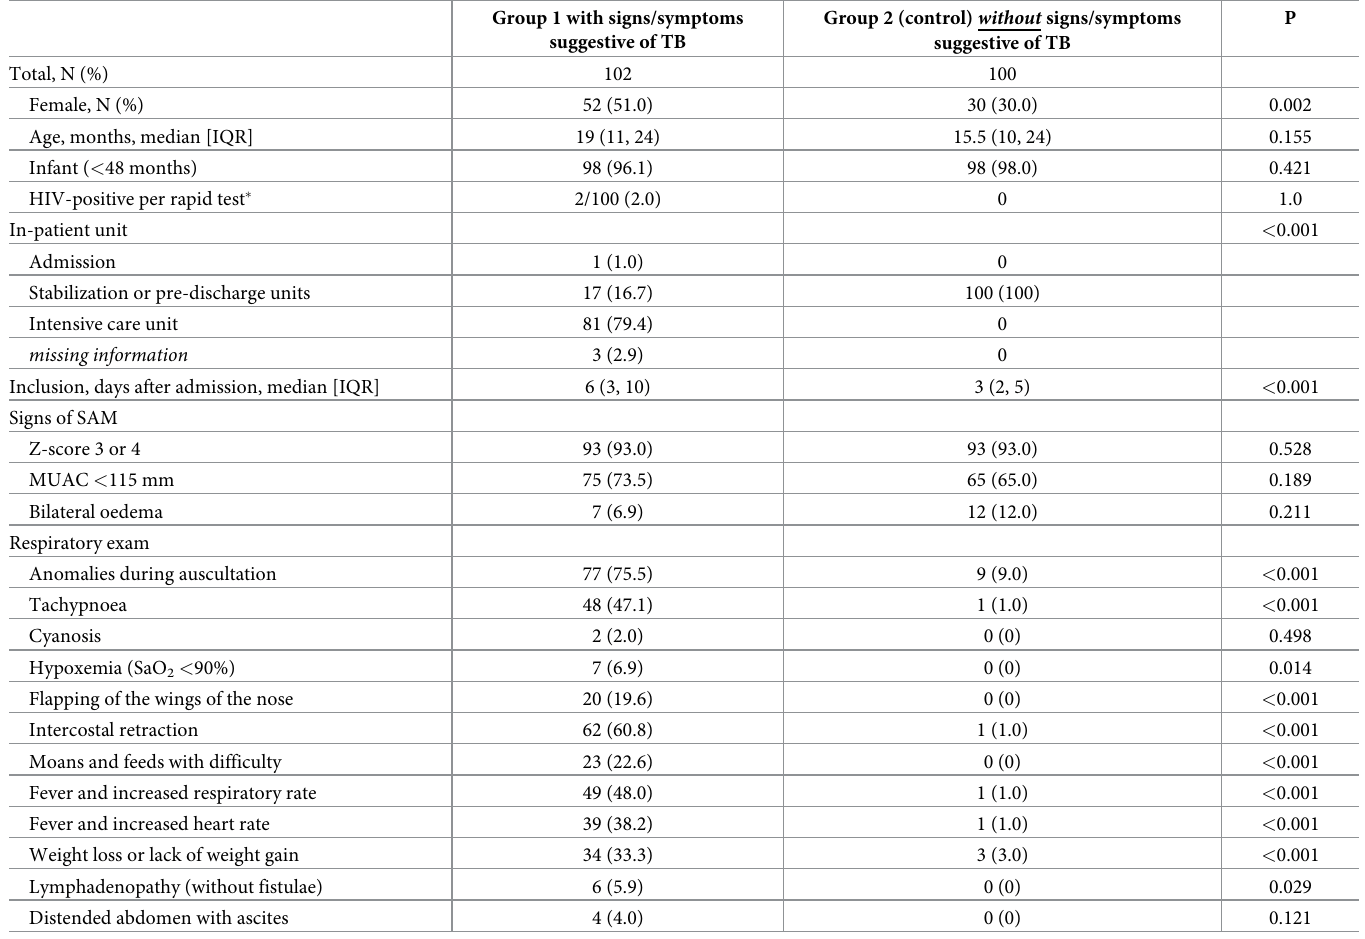
Table 1. Demographic and clinical characteristics at study